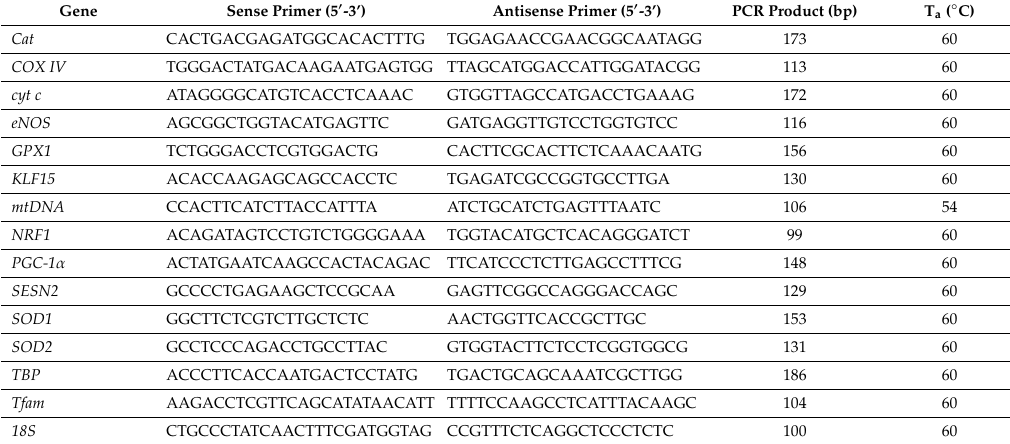
Table 2. Primers for quantitative